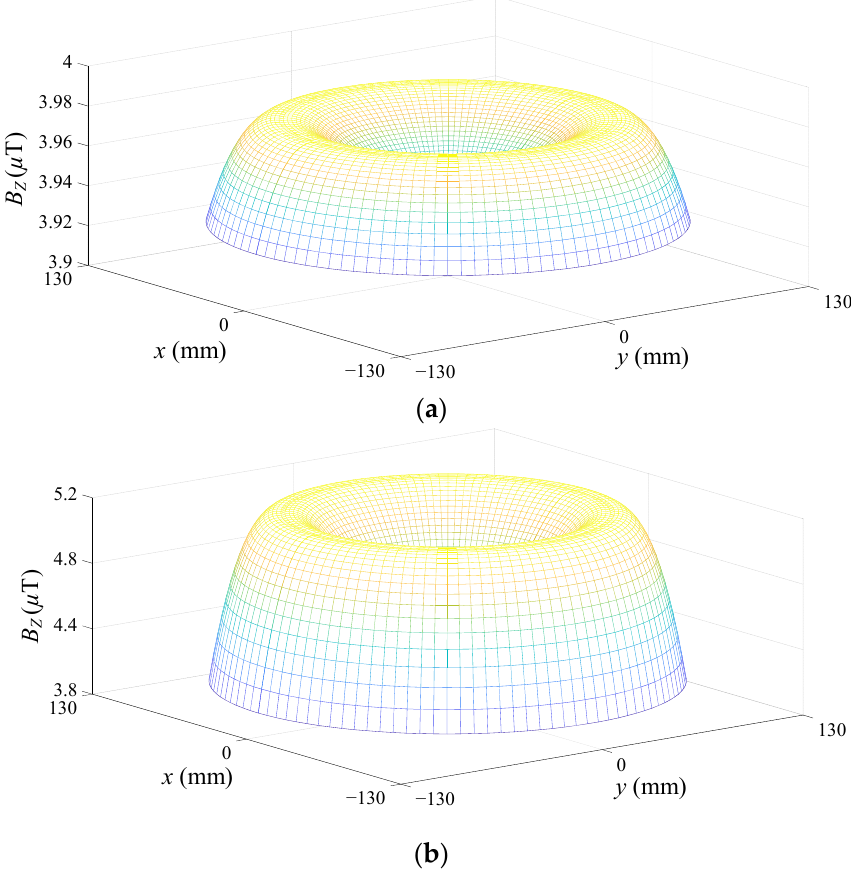
Figure 2. B Z distribution in the S -plane with different h . ( a ) h = 70 mm; ( b ) h = 50 mm.